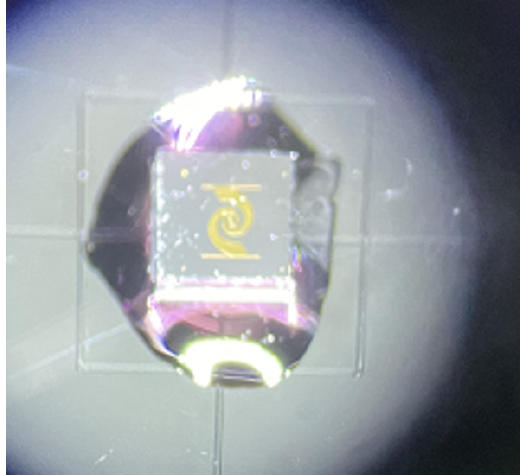
Figure 3. Photograph of the fabricated antenna under the microscope.